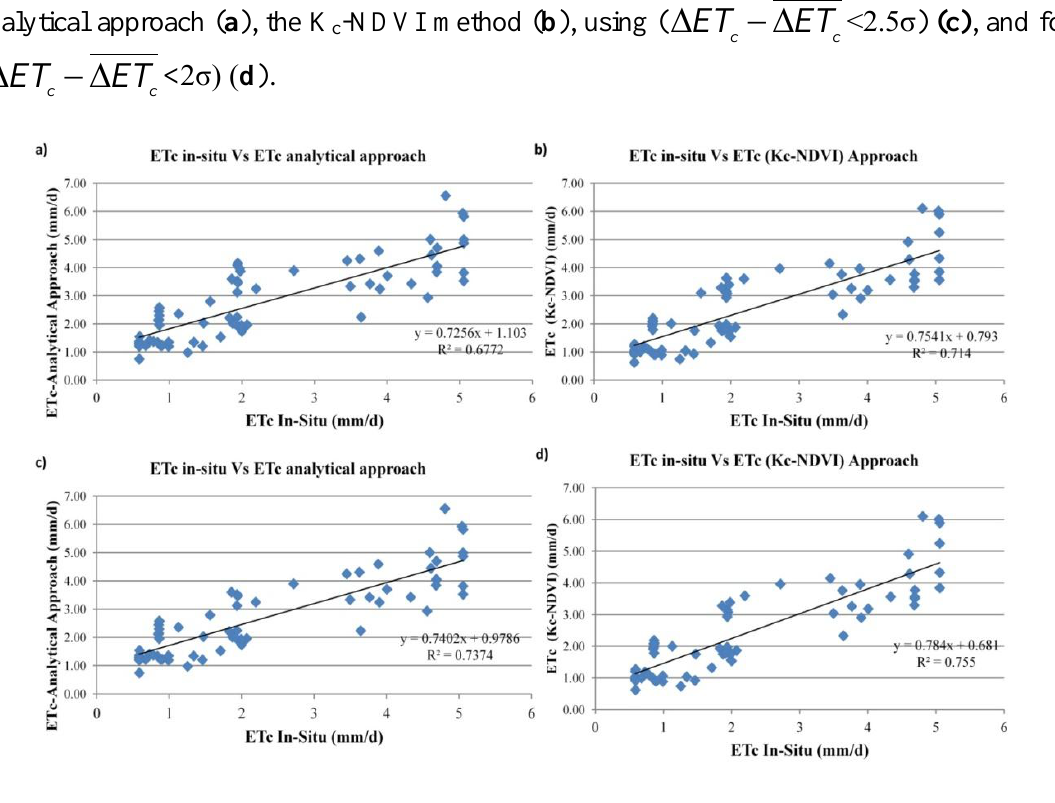
-NDVI method and c